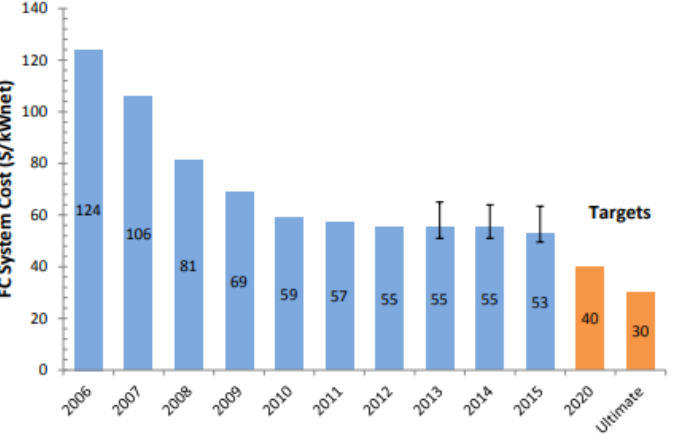
Figure 1. Cost-analysis of an 80 kW net automotive PEMFC-based on projection to a volume of 500,000 units / year [10]. Table 1. US DOE technical targets for PEMs for transportation applications, adapted from Refs. [11– 13].